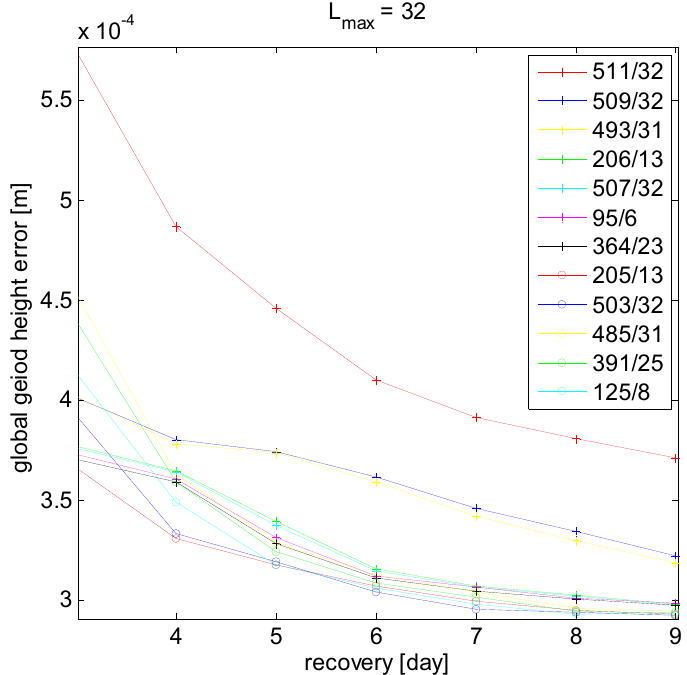
Figure 1. Error RMS in terms of geoid height for the gravity solutions of the Table 1 mission scenarios for maximum spherical harmonic degree and order 32.